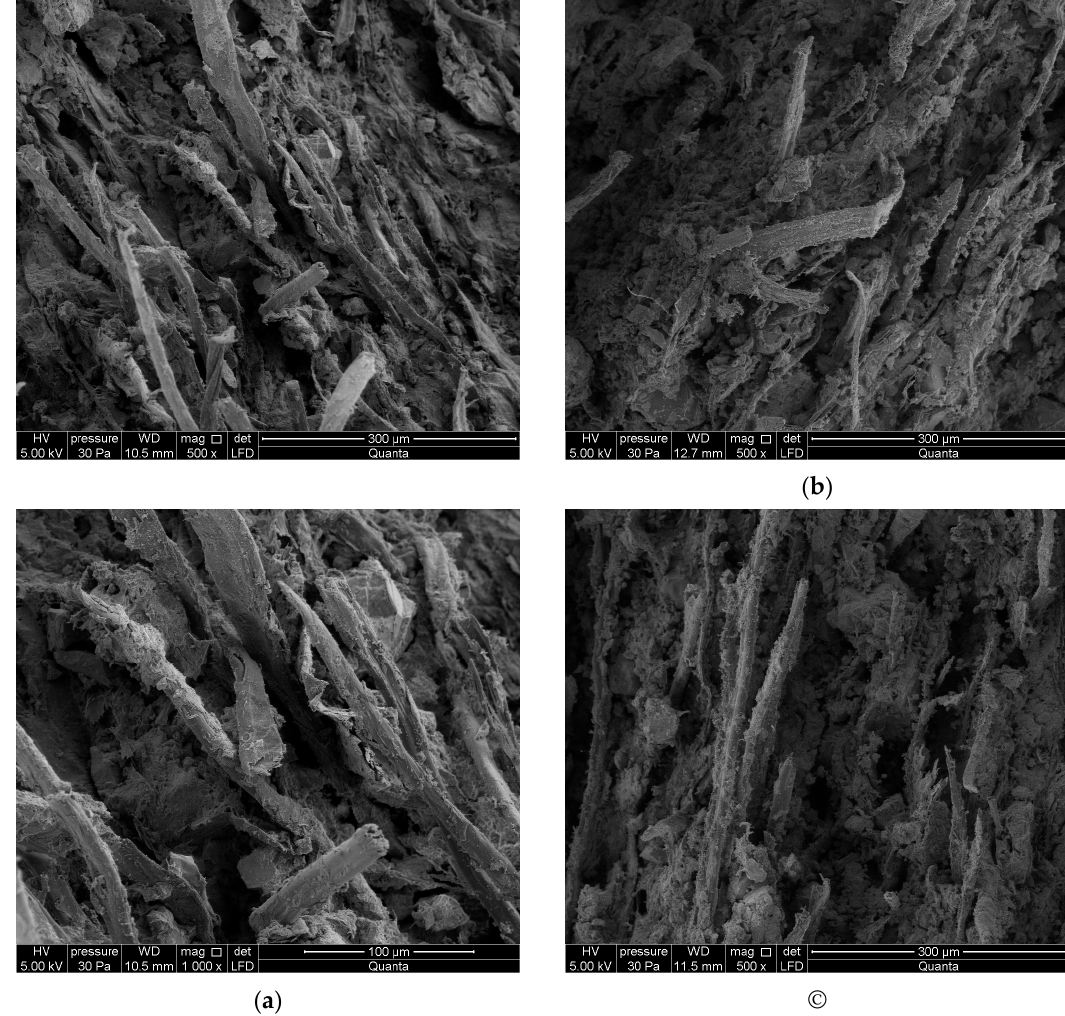
Figure 12. SEM images of boards: ( a ) series A R (magnification 1000 × at top, 500 × at bottom), ( b ) series A 1 , ( c ) series A 10 .